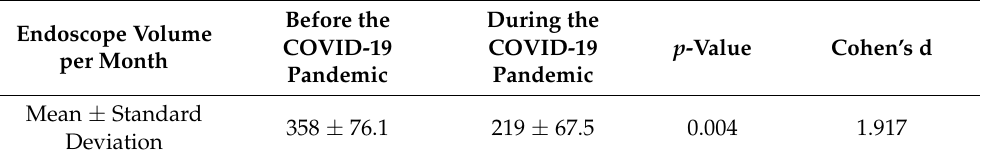
Figure 2. Comparison of Average Accumulative Volume of Endoscopic Services before and During the Pandemic. Table 2. Average Accumulative Volume of Endoscopic Services before and During the COVID-19 Pandemic .